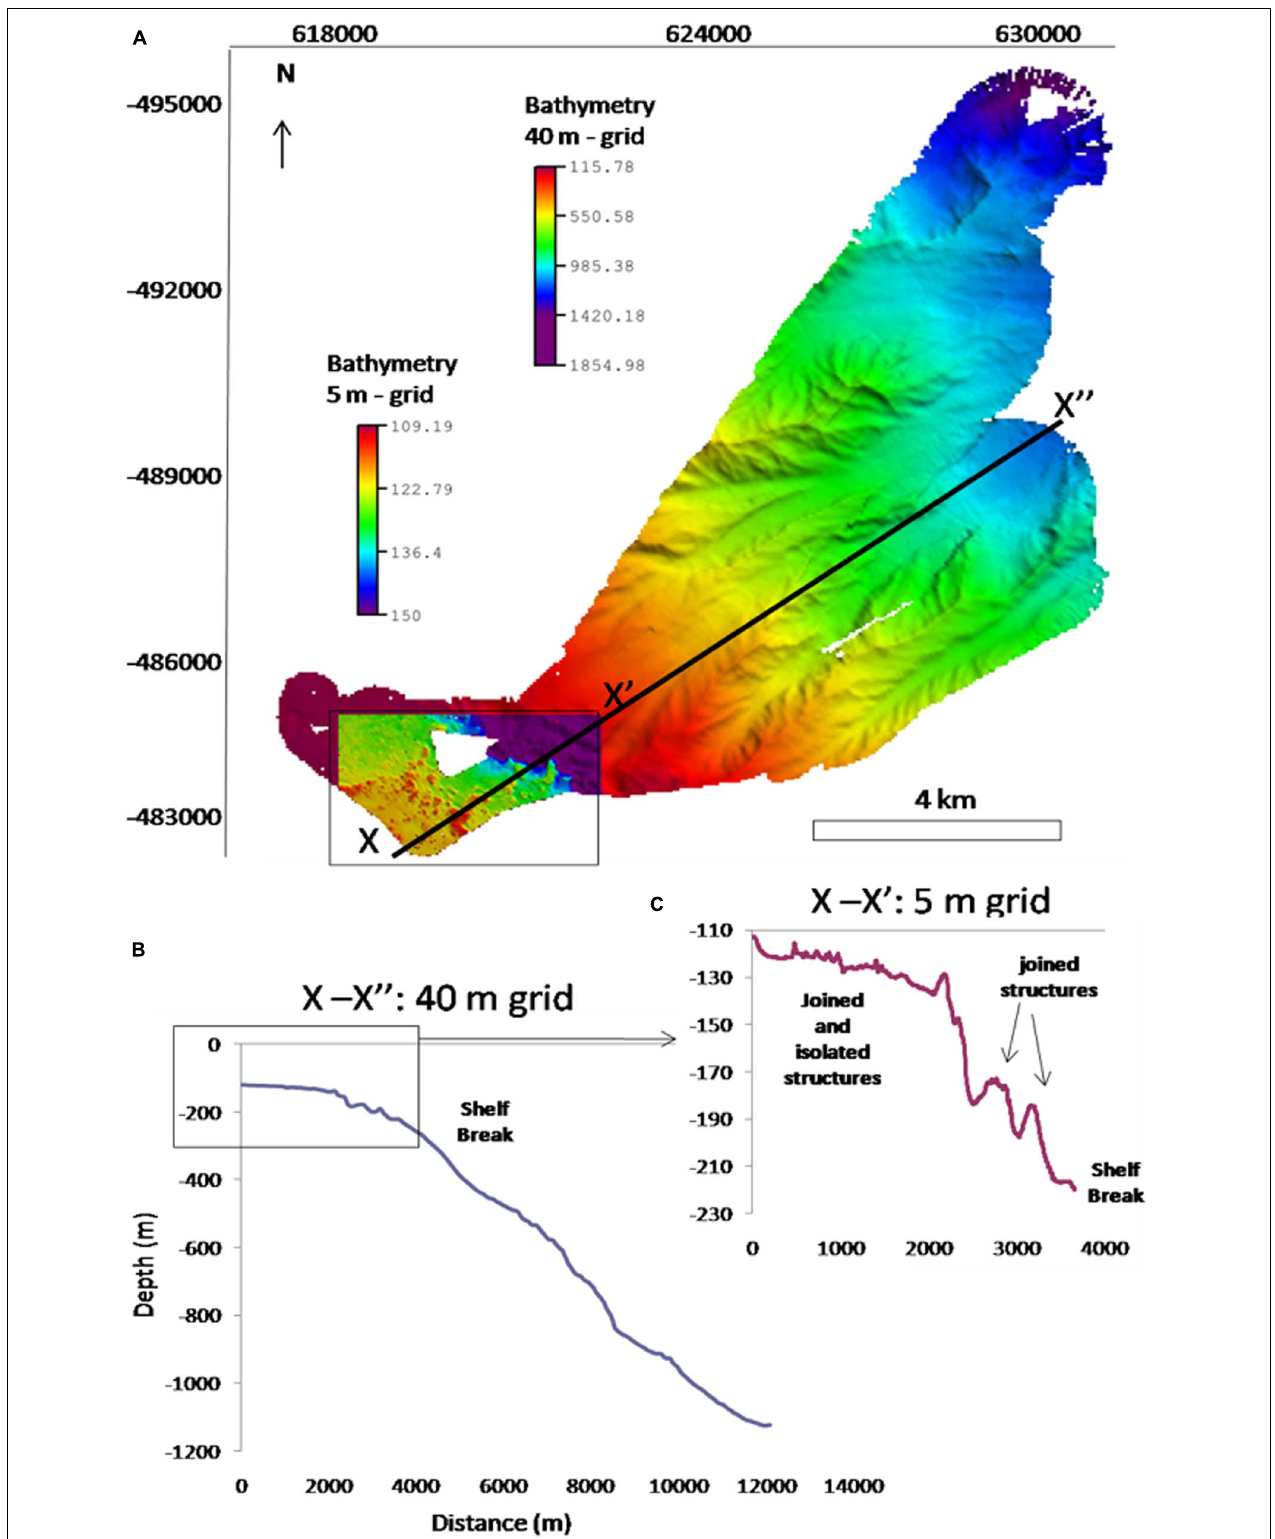
FIGURE 8 | (A) Bathymetric grids from 40- and 5-m resolution, vertical exaggeration of 3; (B) longitudinal profiles for the 40-m grid resolution, highlighting the black square—the 5-m grid; (C) longitudinal profile showing isolated and joined reefal structures and the shelf break at approximately 250- to 300-m water depth.